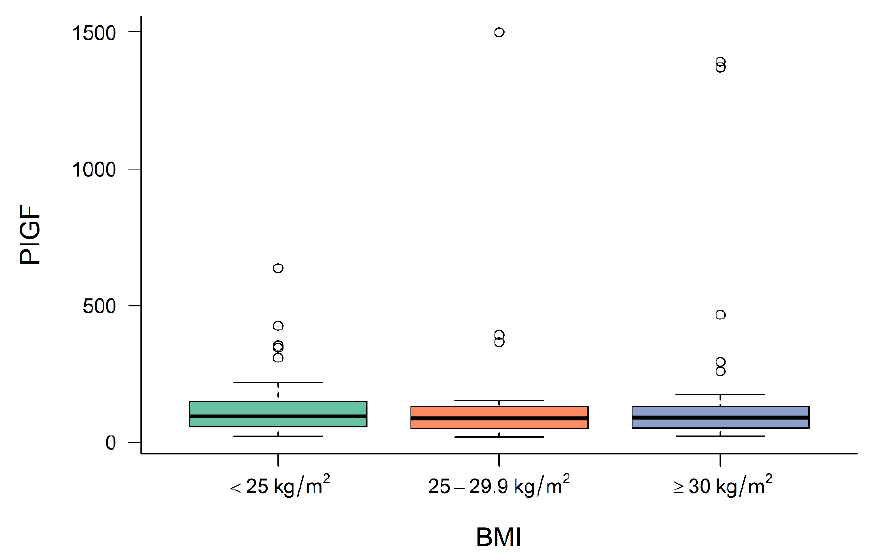
Figure 3. Level of PIGF at diagnosis in normal-weight, overweight and obese women. BMI body mass index, PIGF placental growth factor.